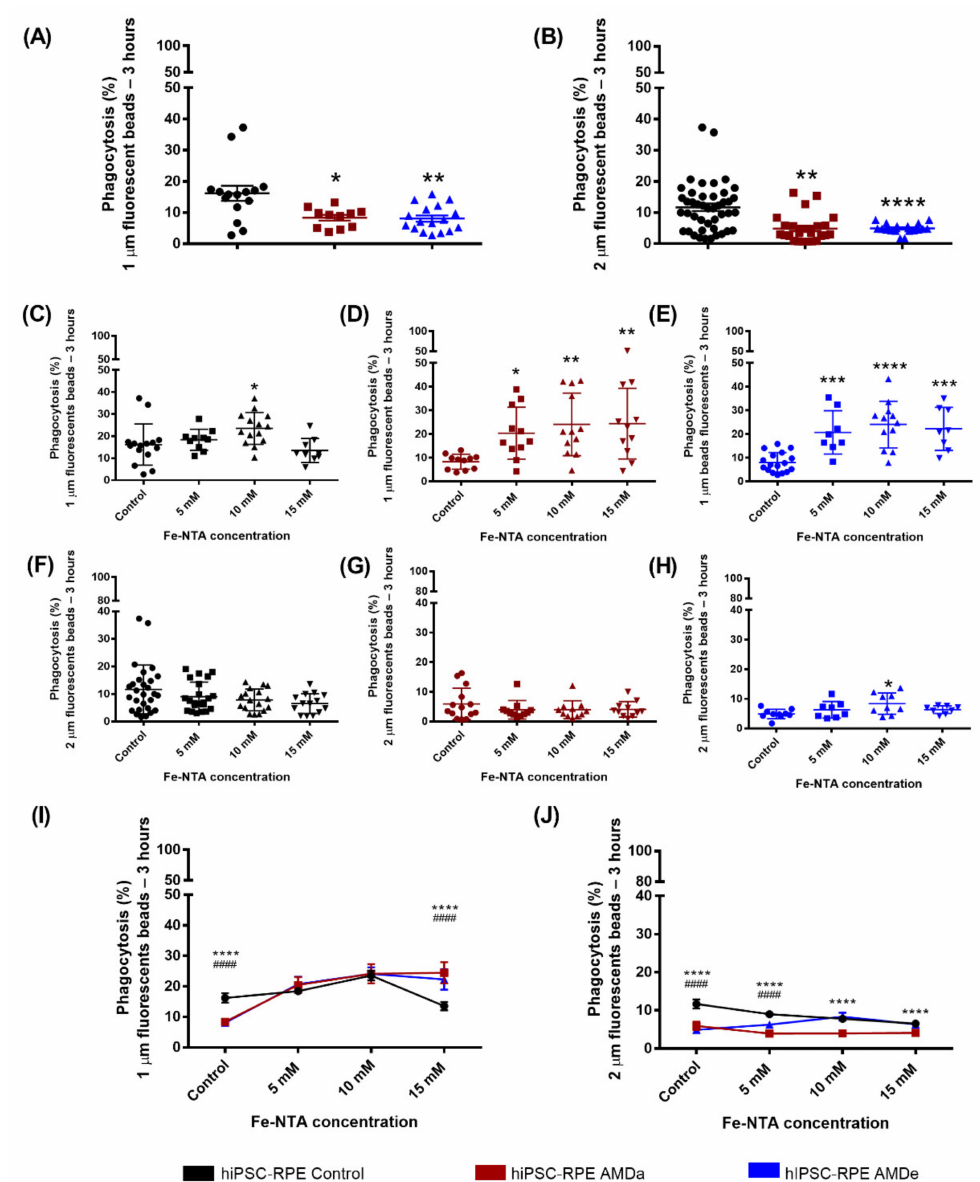
Figure 1. Non-specific phagocytosis function of hiPSC RPE Control and AMDa/e cell lines in both basal and oxidative stress conditions. Non-specific phagocytosis quantification in hiPSC-RPE Control (N = 6, n = 3), AMDa (N = 6, n = 3) and AMDe (N = 3, n = 3) cells in basal condition ( A , B ) and 24 h oxidative stress condition induced by different Fe-NTA concentrations ( C – J ). For I and J, comparison between hiPSC Control and AMDa (*) or AMDe (#). Statistical analysis: Kruskal–Wallis. * p < 0.05 ** p < 0.01 *** p < 0.001 ****, #### p <